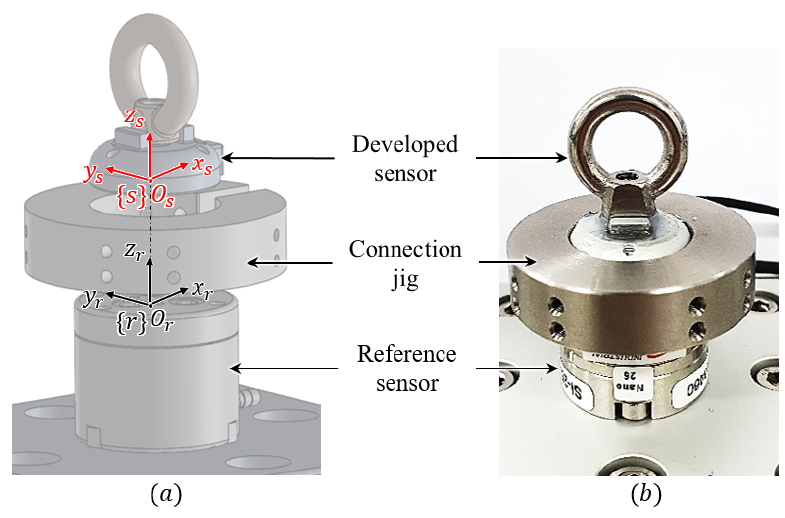
Figure 10. Experimental setup for comparing the three-axis force/torque data measured by the developed sensor with the reference sensor. ( a ) Calibration setup used to obtain the measured data from the developed sensor and the reference sensor. ( b ) Actual assembled state.